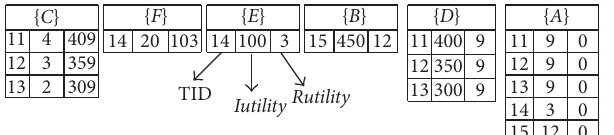
Figure 3: The constructed utility-list structures for the inserted transactions.